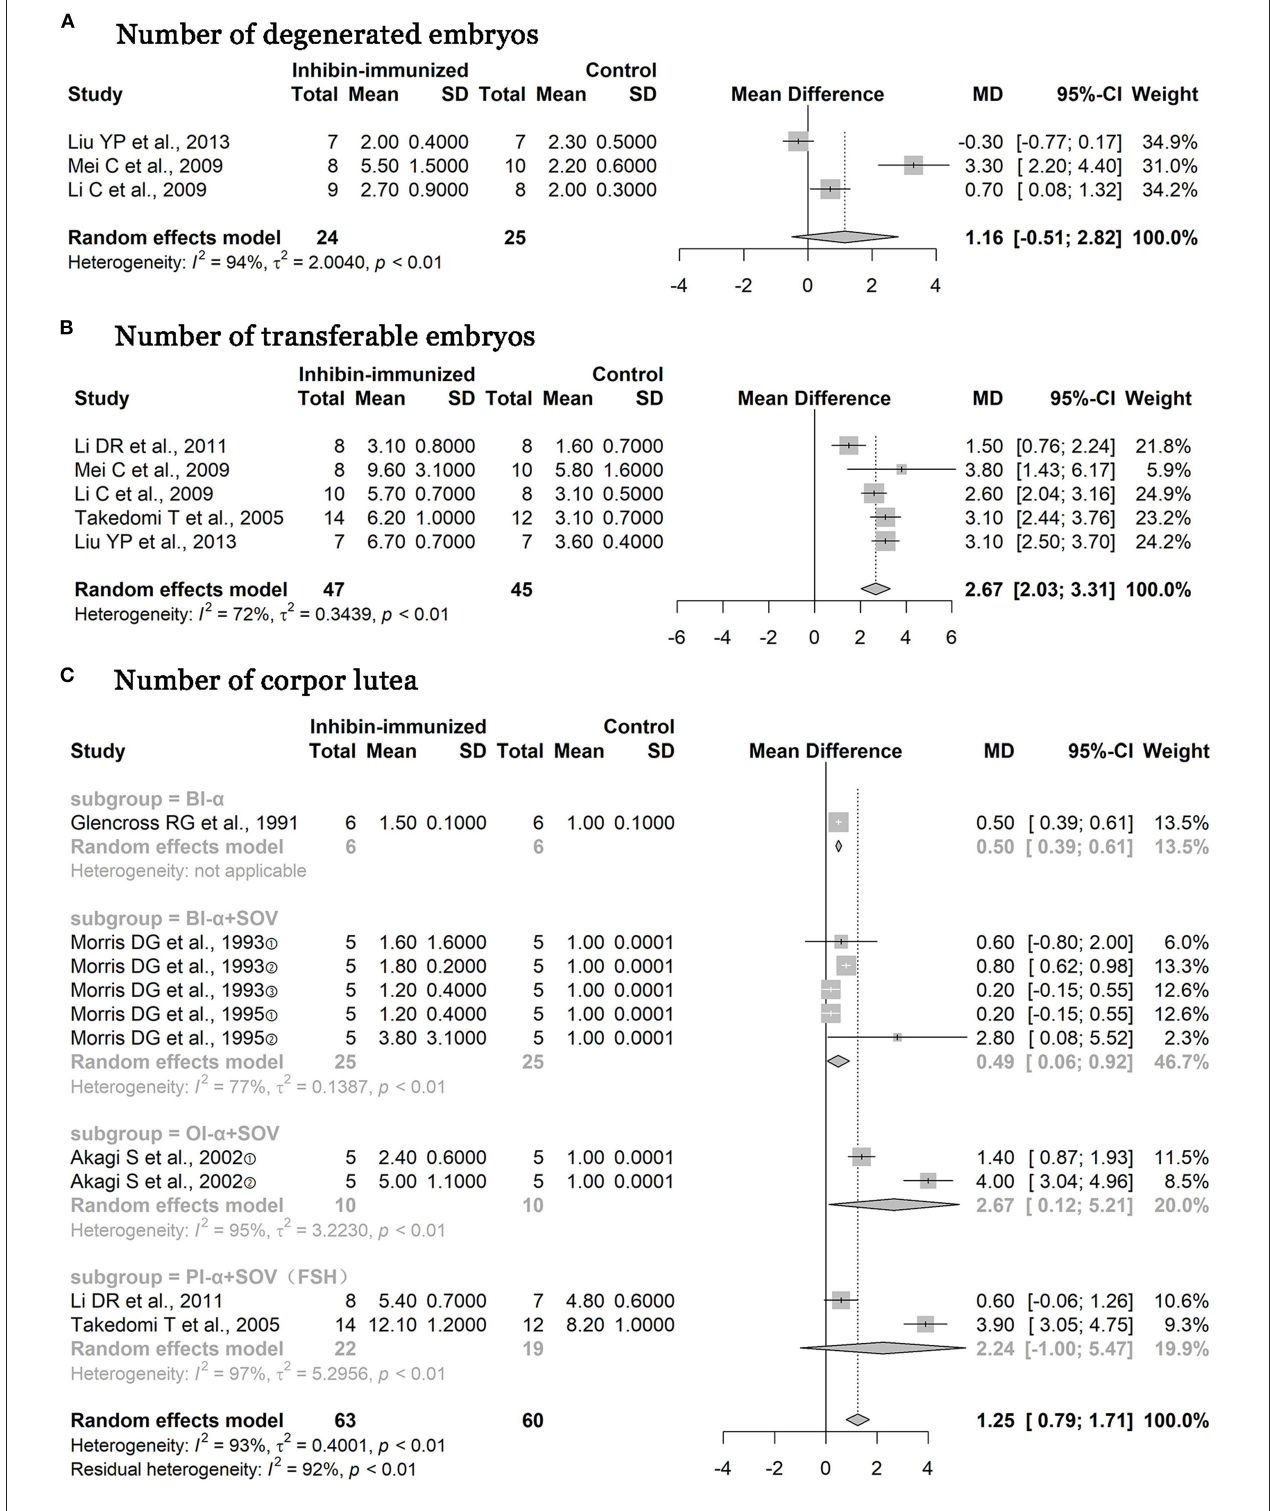
FIGURE 7 | Meta-analysis of numbers of degenerated embryos, transferable embryos, and corpora lutea. BI- α , bovine inhibin α subunit; PI- α , porcine inhibin α subunit; OI- α , ovine inhibin α subunit; SOV, superovulation; FSH, follicle-stimulating hormone.